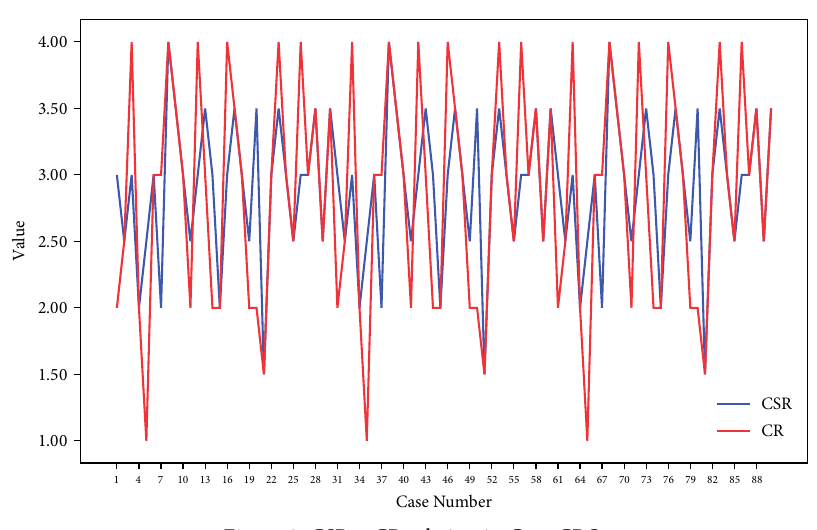
Figure 9. CSR – CR relation in Case